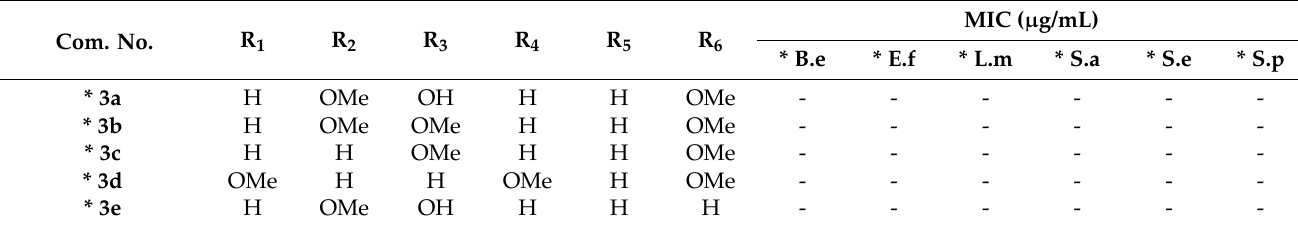
Figure 14. Chemical structures of mentioned flavonoids and their related SAR for antibacterial activity [80]. Table 8. Antibacterial activities of naturally occurring isoflavones 3a – o .